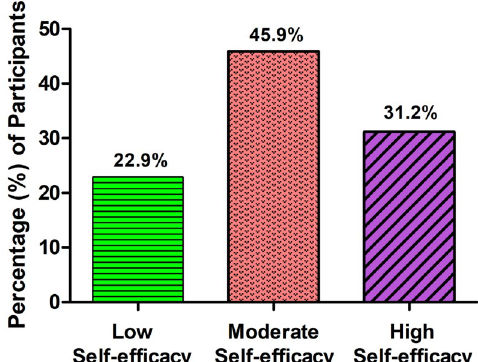
Fig. 1. Total SE scores of Na jran University students during the period of COVID-19 pandemic (n=